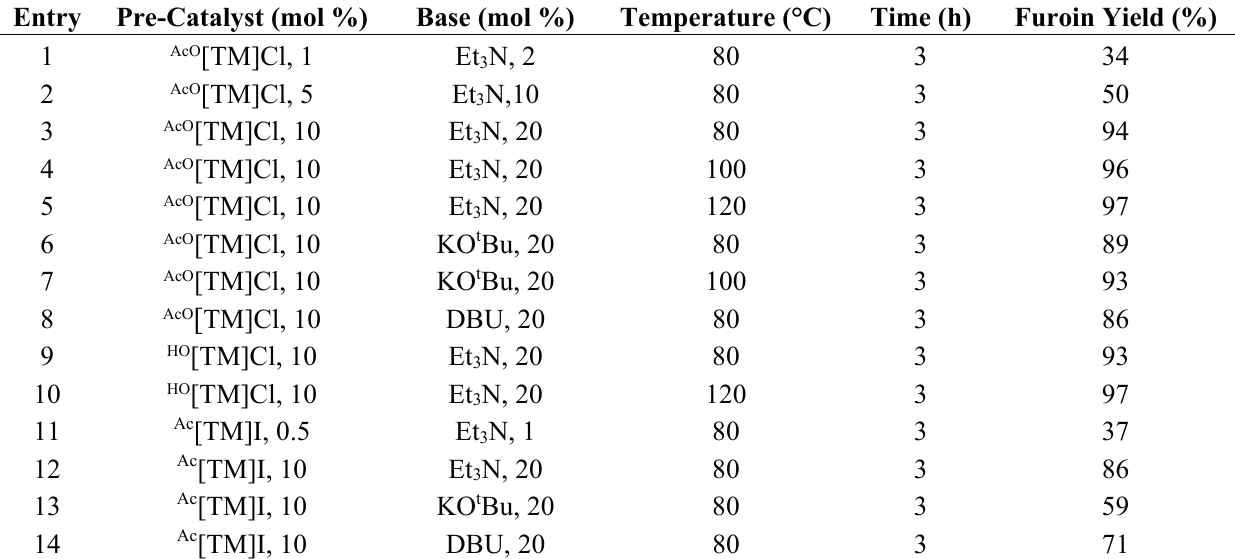
Table 2. Results of self-coupling of HMF to DHMF catalyzed by thiazolium ILs and